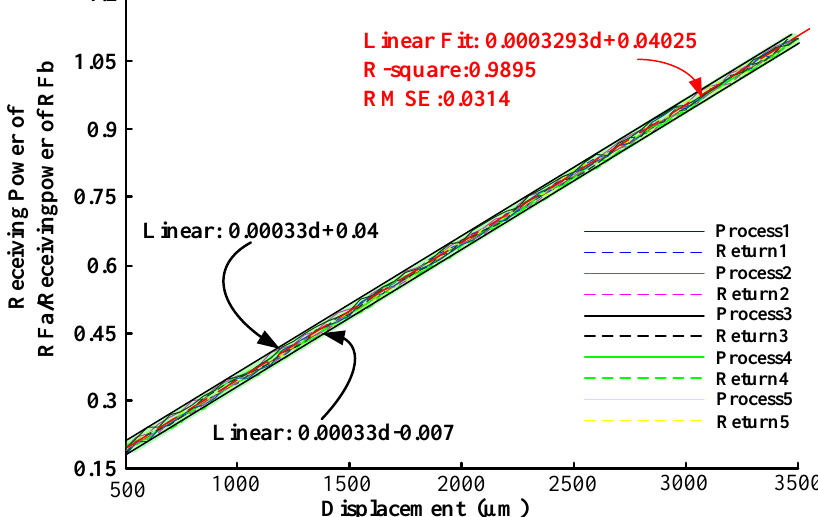
Figure 14. Sensor static calibration station.